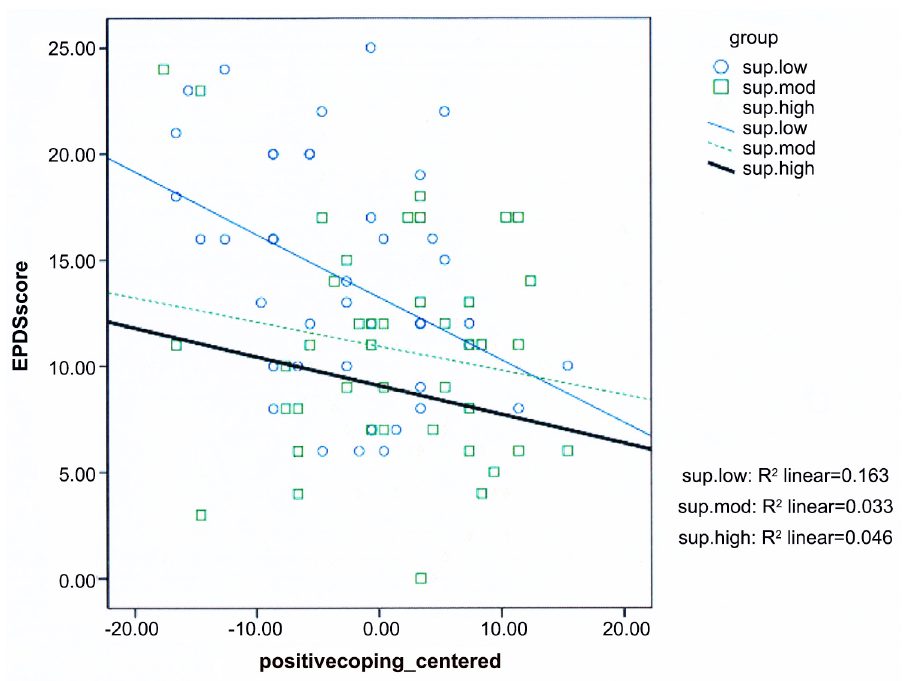
Fig 1. Effect of positive coping style on EPDS score as a function of subjective social support. * “ sup. low ” means low level of subjective social support. * “ sup.mod ” means moderate level of subjective social